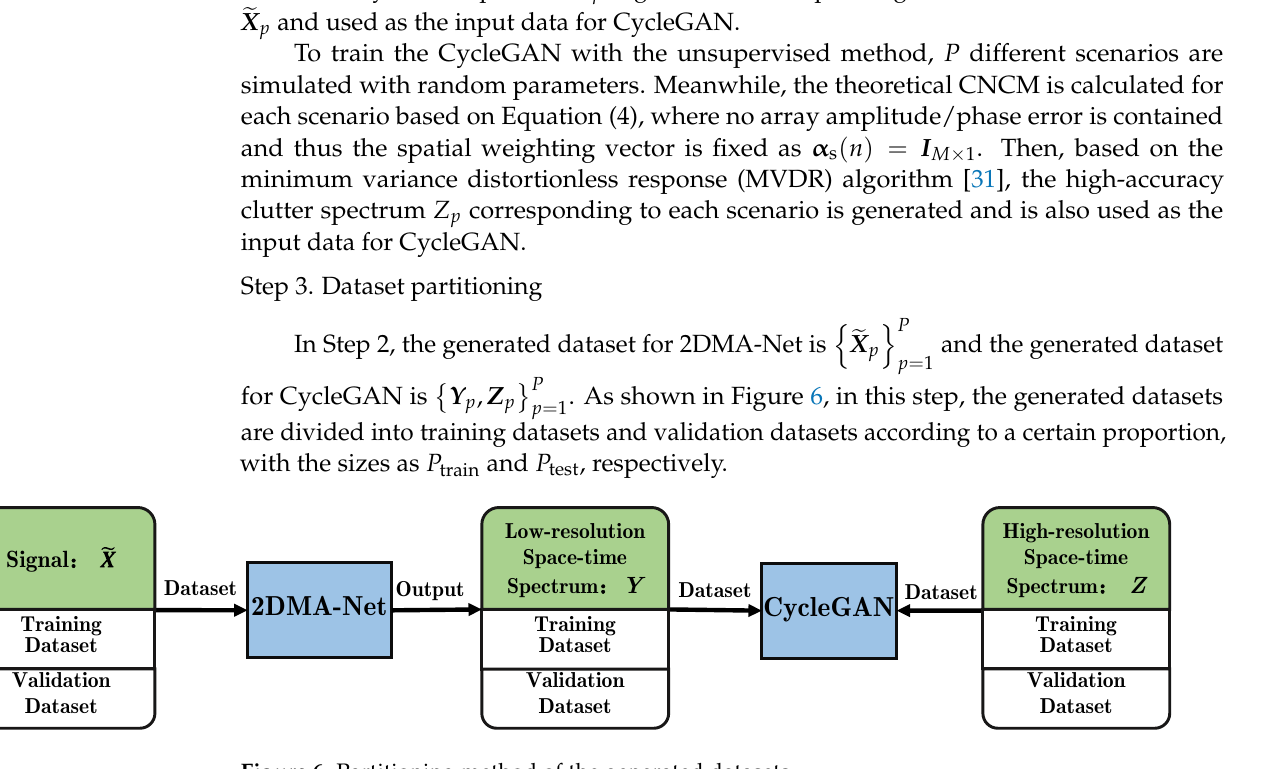
Figure 6. Partitioning method of the generated datasets.